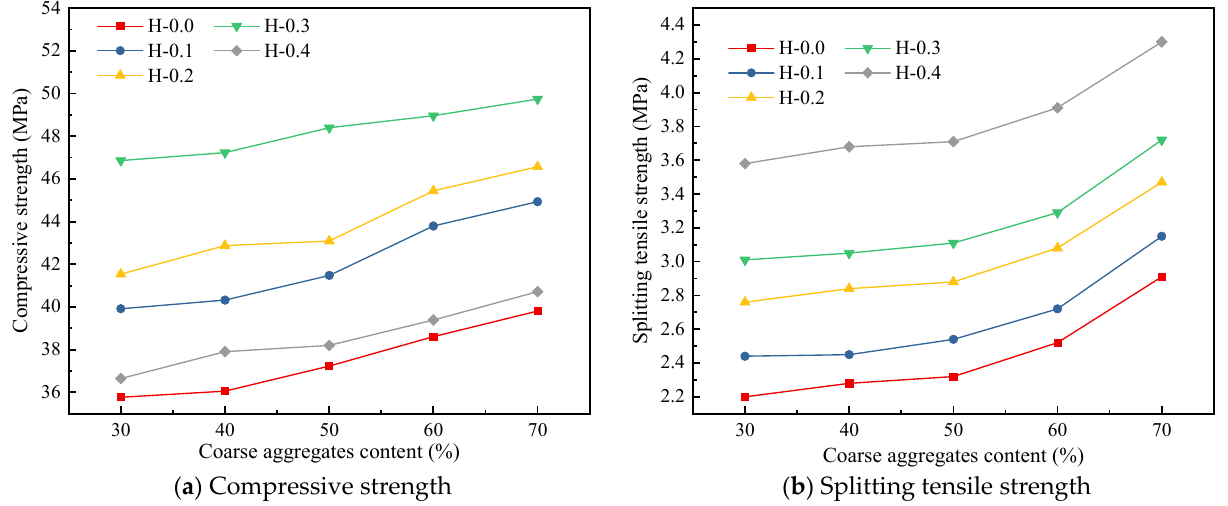
Figure 31. Simulated strength values of hybrid fiber ‐ reinforced LHPCC with different coarse aggre ‐ gate contents.